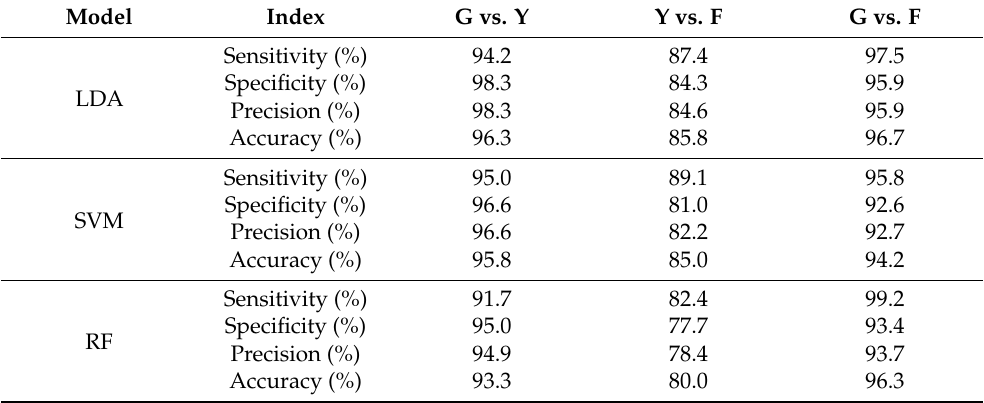
Figure 6. LDA model diagram based on morphological and spectral data of alfalfa seeds of ( A ) different maturity levels and ( B ) harvest years. Table 3. Prediction of alfalfa seeds with different maturity levels by LDA, SVM and RF models.